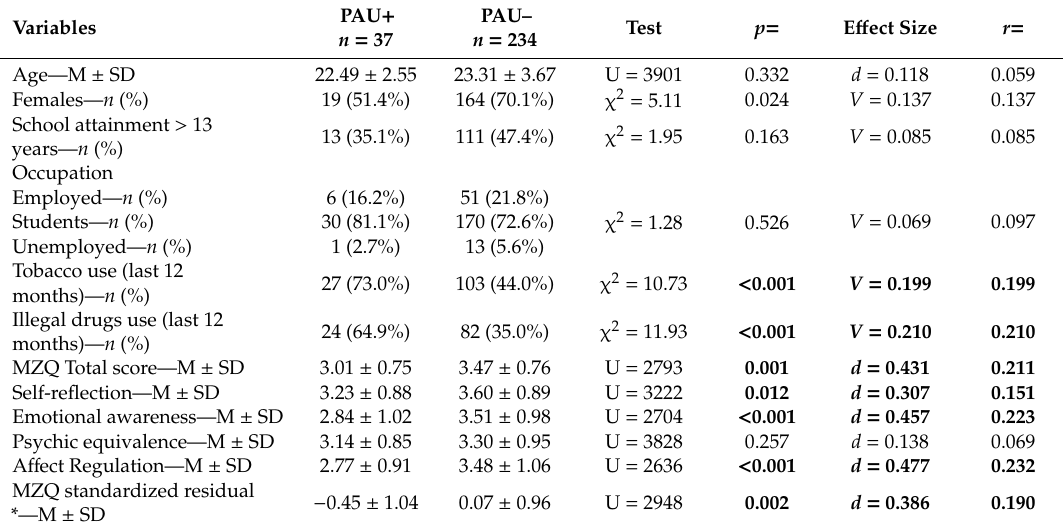
Table 3. Di ff erences between individuals with and without PAU according CAGE cut-o ff ≥